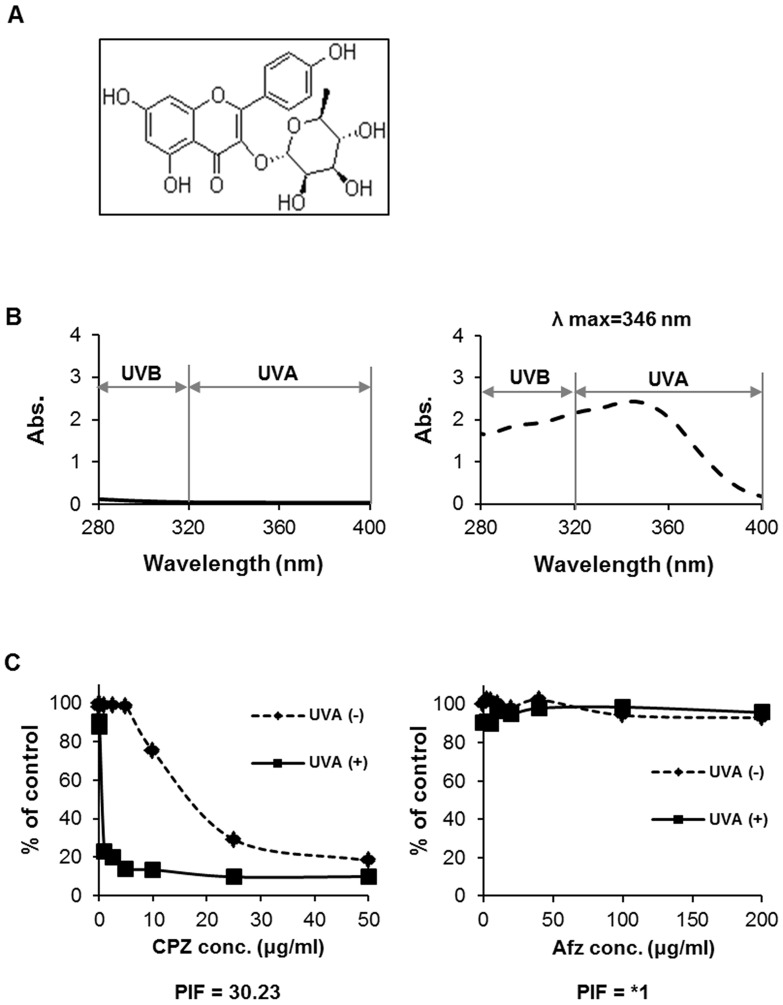
UV-absorbing properties and phototoxicity of afzelin.
A. Chemical structure of afzelin. B. The UV absorbance spectra for DMSO and afzelin (dotted line). Spectra were acquired on a BioTek UV-Vis spectrometer. C. Phototoxicity data for afzelin and chlorpromazine (CPZ), the positive control, in the 3T3 NRU phototoxicity test. Balb/c 3T3 cells were treated with different concentrations of the tested compounds and irradiated with UVA (5 J/cm2). Dotted line indicates the response in the 3T3-NRU assay in the absence of UVA irradiation and the solid line indicates the response in the presence of UVA (5 J/cm2) irradiation. Representative data, n = 3 (B–C).